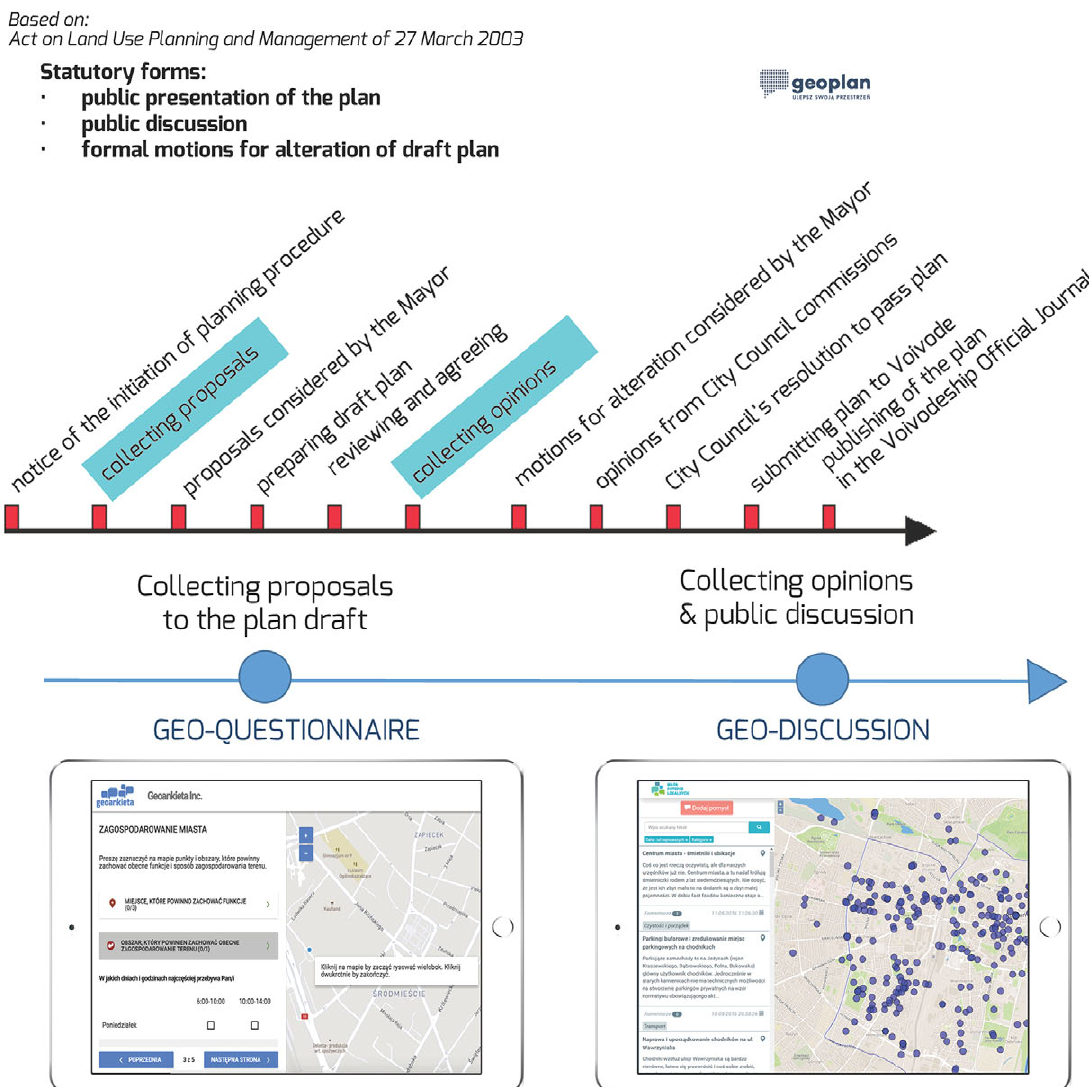
Fig. 12. Public participation in urban planning in Poland and Web-based applications of geo-questionnaire and geo-discussion (by E. Bąkowska et